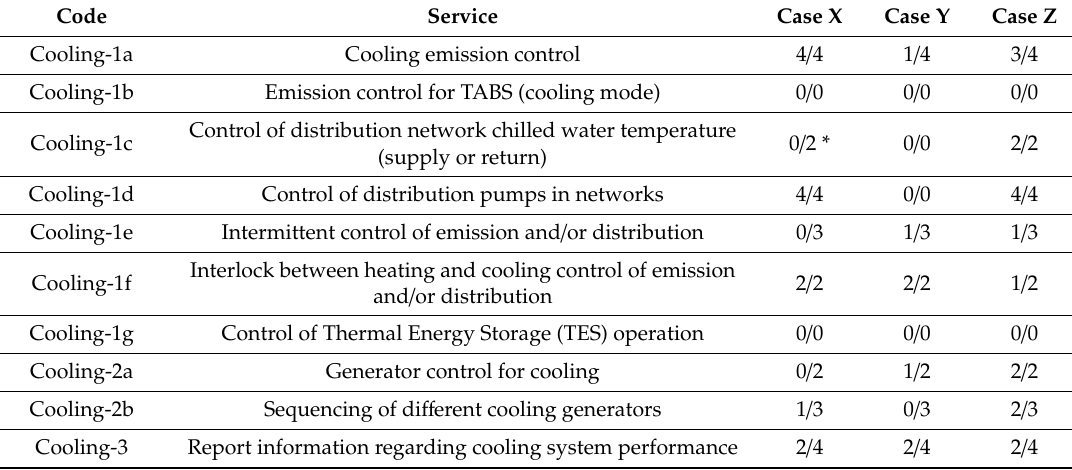
Table 5. The functionality levels in the main domain of cooling.